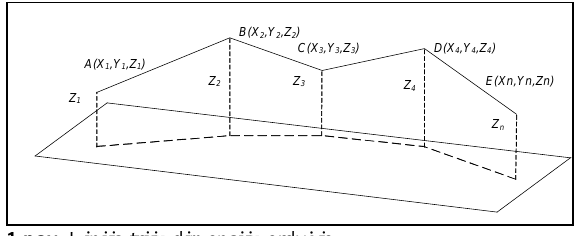
Fig 1. Line in three-dimensional